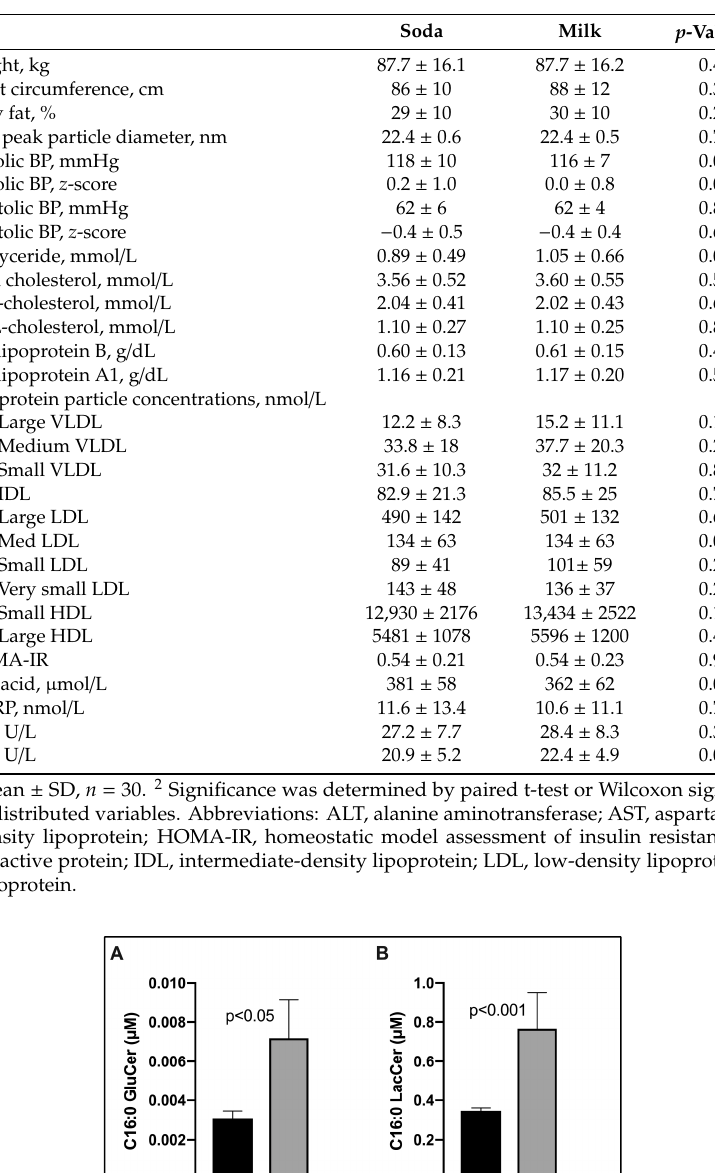
Table 3. Matched pair analyses of the e ff ects of soda or milk on study outcomes 1 .